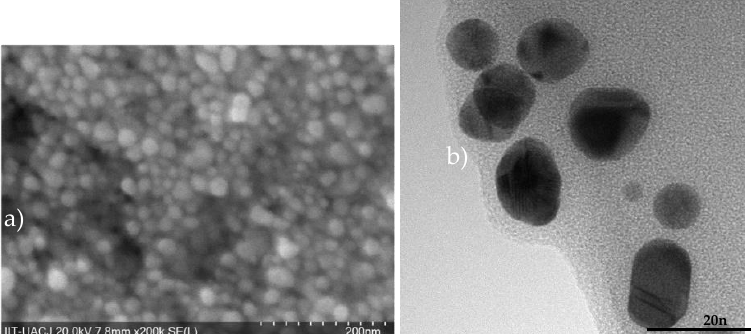
Figure 8. ( a ) SEM photo and ( b ) TEM image of AuNP-Fl.